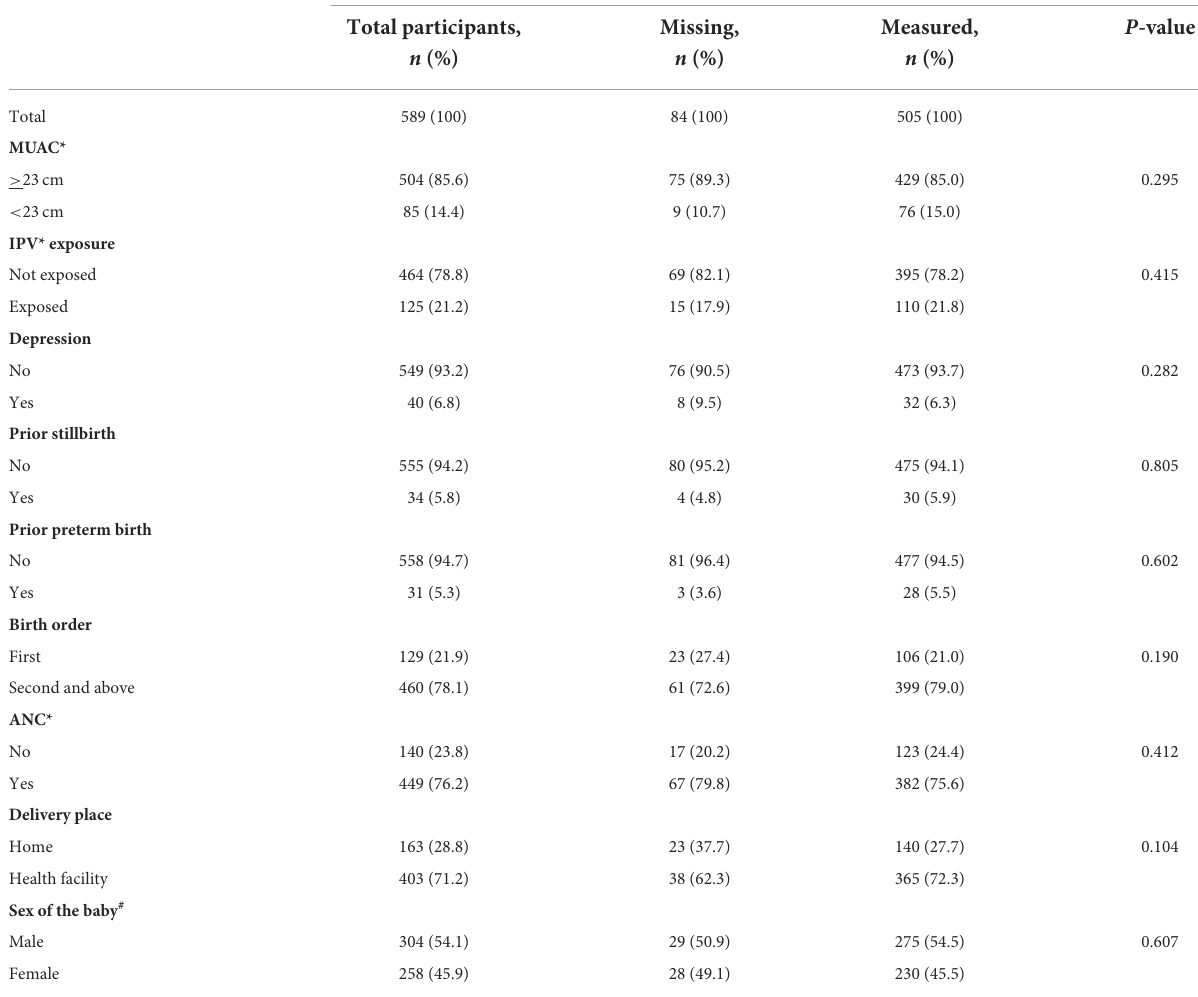
TABLE 1b Clinical characteristics of pregnant women enrolled in the study whose baby’s birth weight was measured or not, in Wondo Genet district, Ethiopia, 2017.